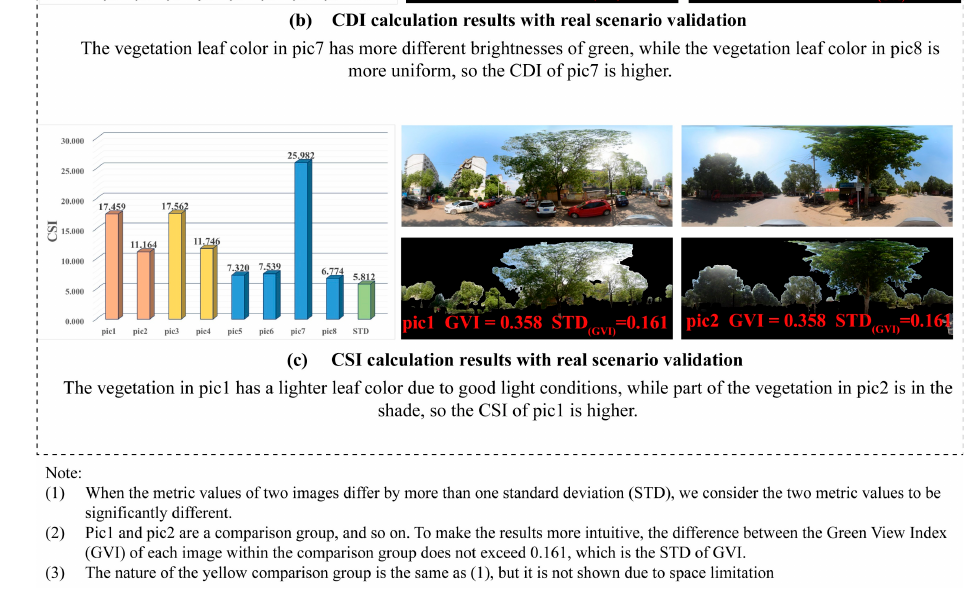
Figure A2. Numerical comparison of TDE, CDI, CSI, and actual scene verification.